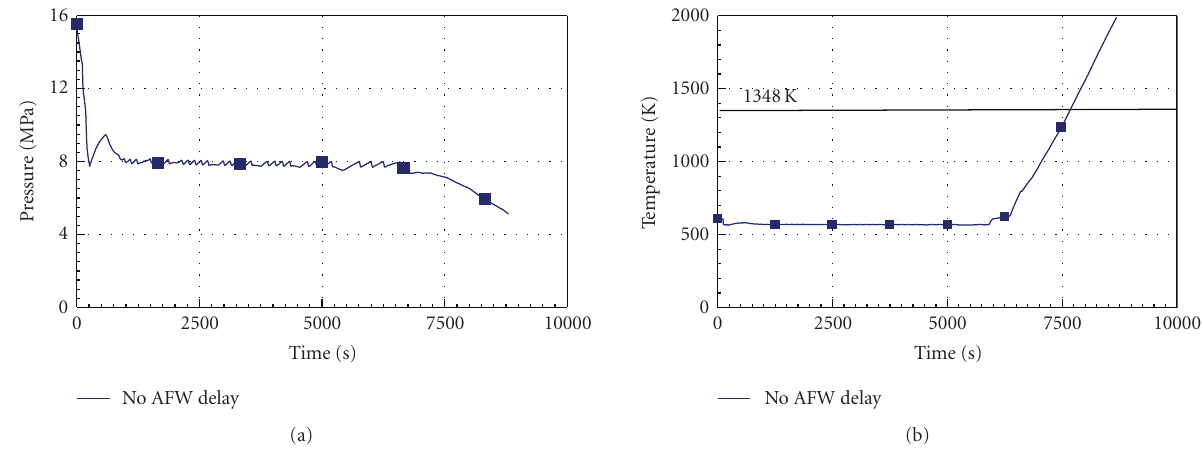
Figure 3: Scenario with AFW available: (a) RCS pressure, (b) core cladding temperature. Table 2: Operator actions delay for 2.54 cm LOCA